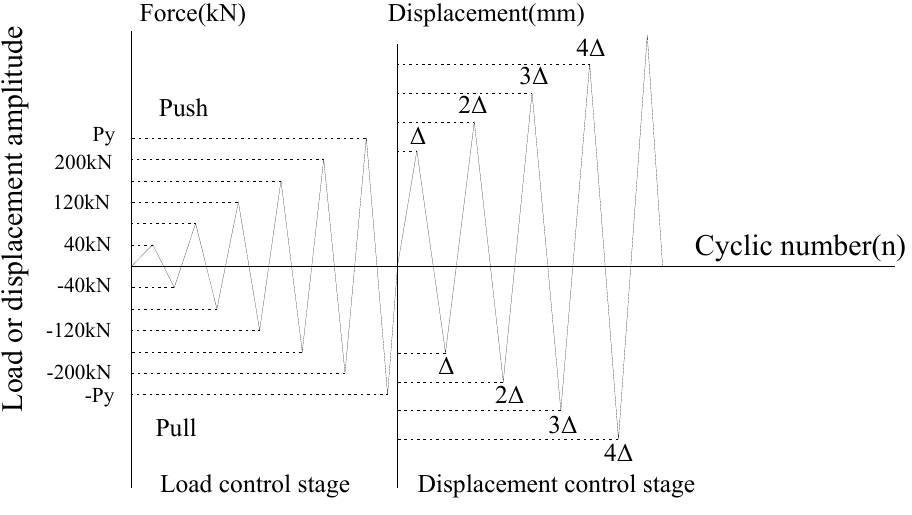
Figure 6. Lateral loading process.